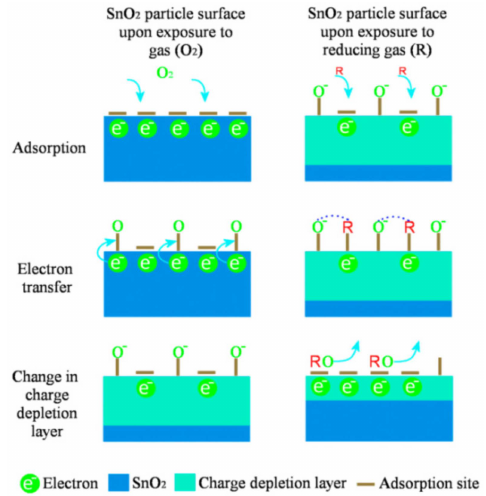
Figure 2. Schematics of the SnO 2 sensing response towards oxidizing and reducing gases. Reprinted from